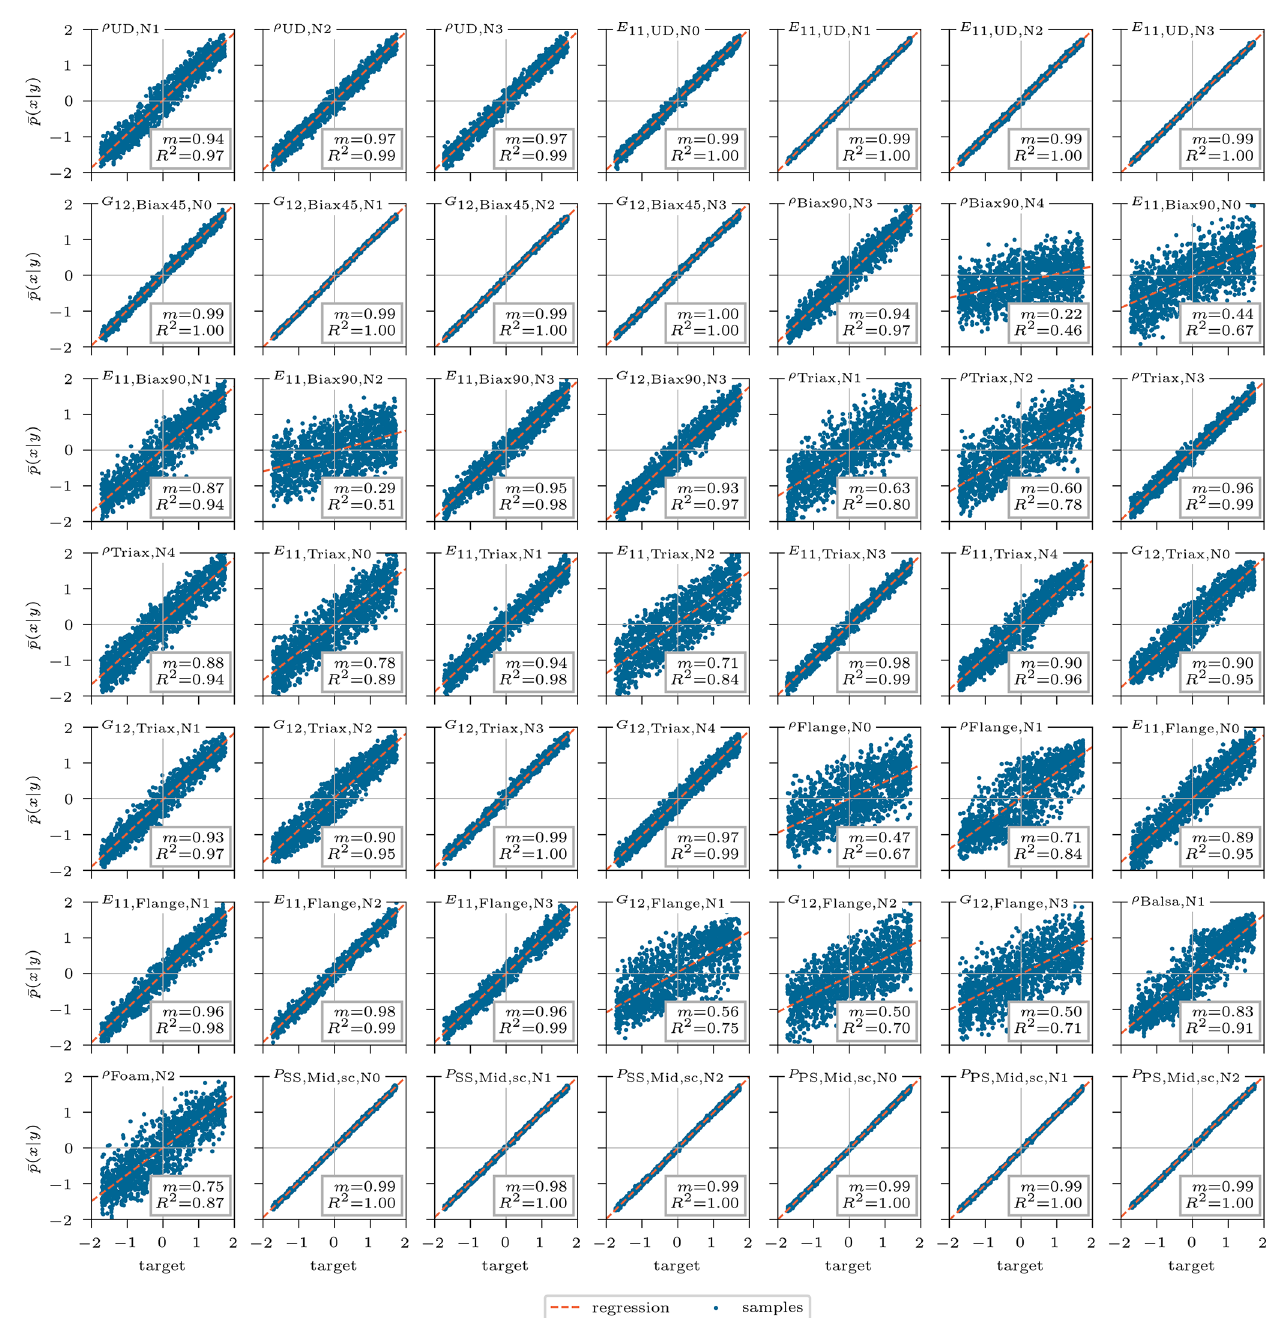
Figure 9. Standardized mean of posterior prediction x of the updated inputs over the corresponding target standardized value for the 5000 test samples. The coefficient of determination and a corresponding linear regression line are shown. The corresponding parameter description of the features can be found in Table